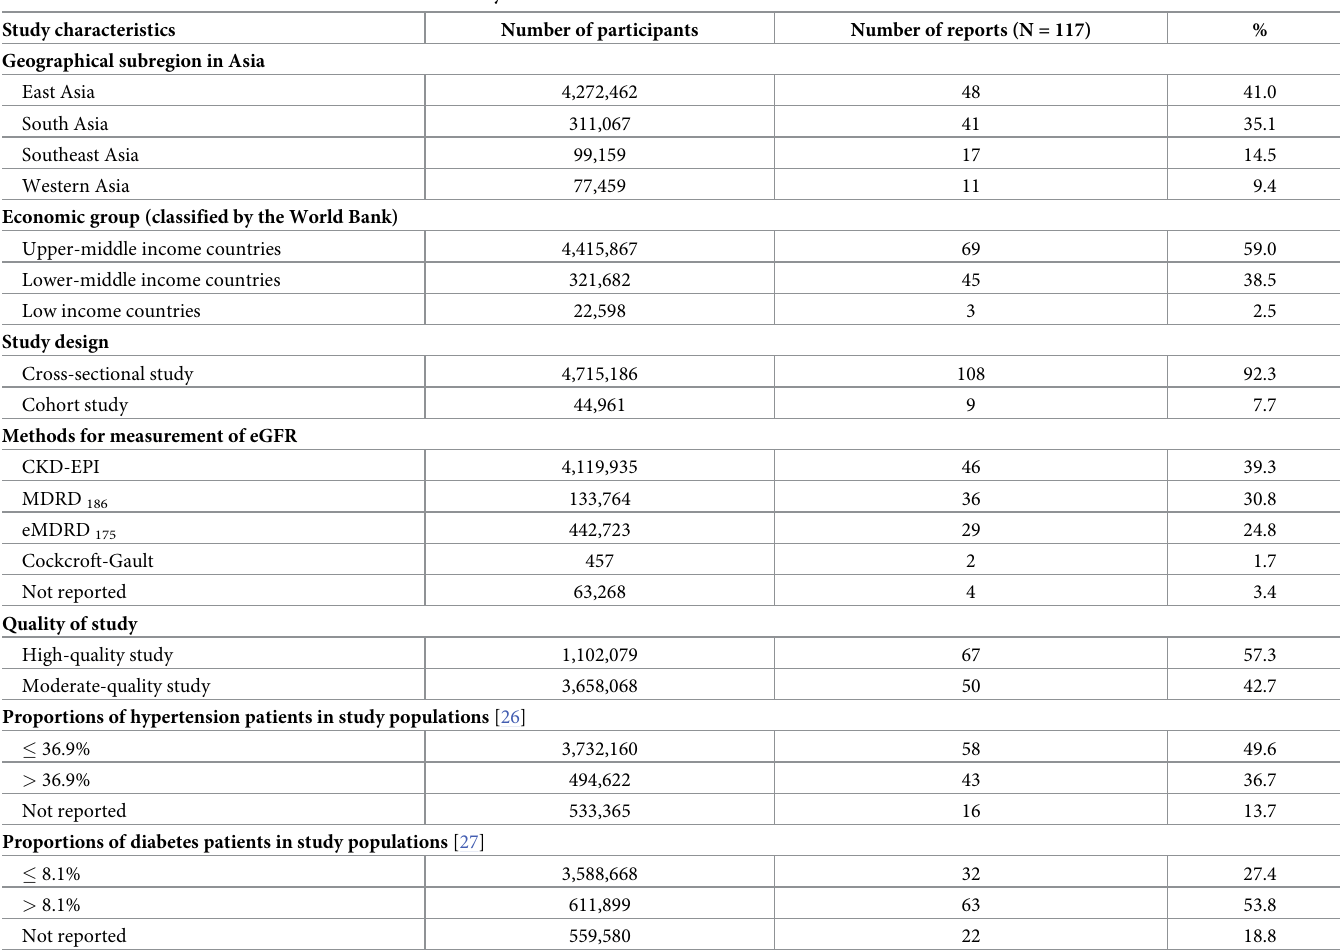
Table 1. Characteristic of studies included in the